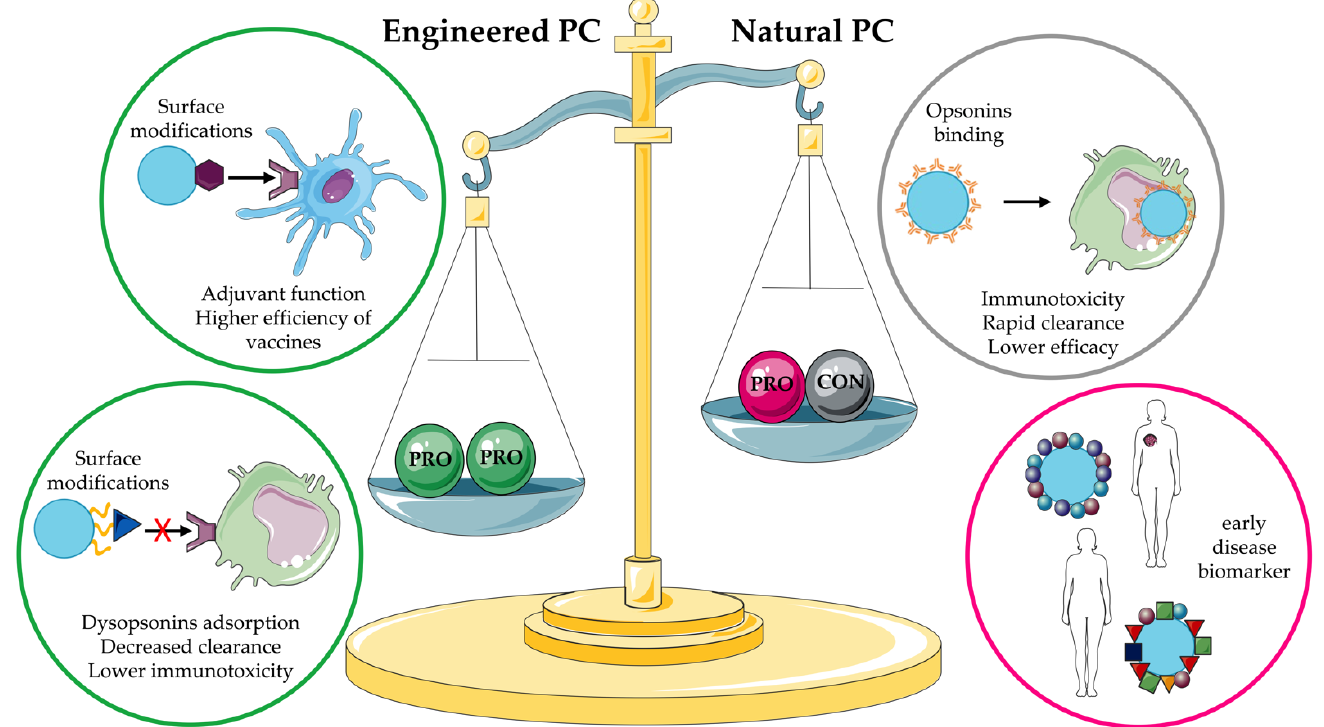
Figure 9. Pros and cons of the natural and engineered PCs. The figure was partly generated